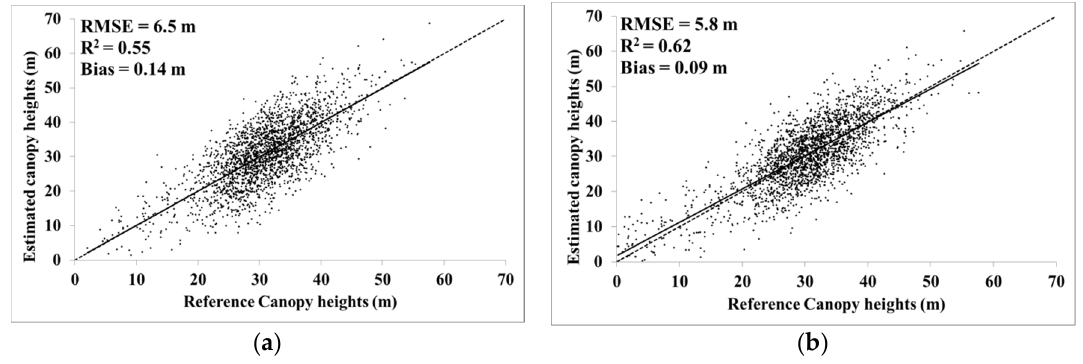
Figure 3. Wall-to-wall map of French Guiana with Random Forest regressions using as reference data the canopy height estimates from: ( a ) GLAS dataset; and ( b ) LD_cal dataset.